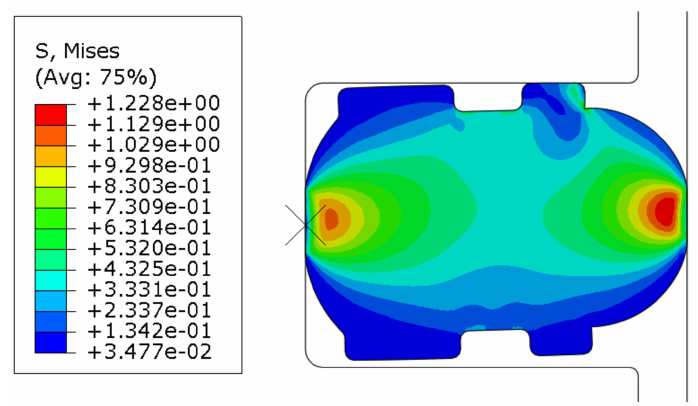
Figure 8. Contact deformation of sealing ring under compression of 0.5